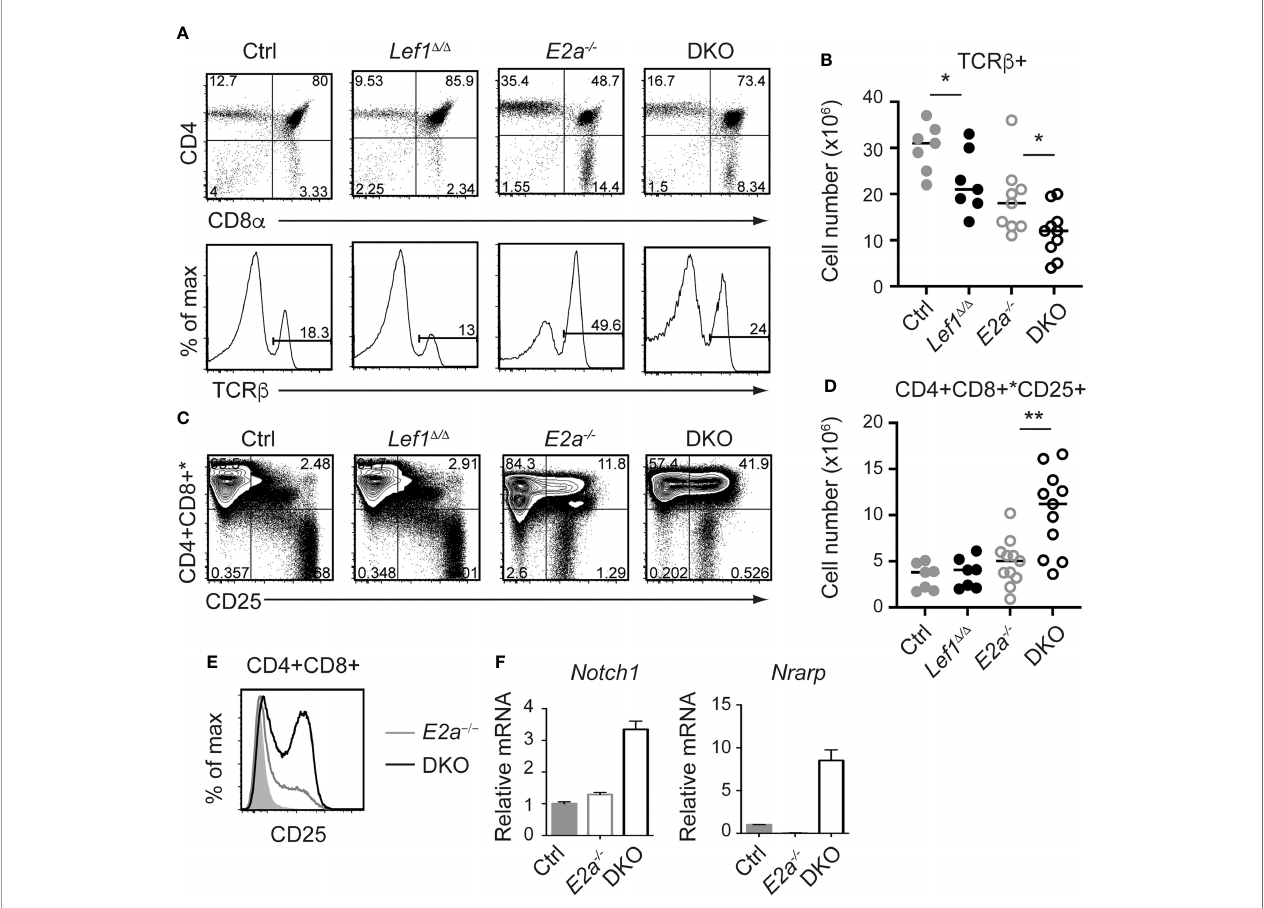
FIGURE 4 | LEF1 restrains expression of CD25, Notch1 , and Nrarp in E2a -/- CD4 + CD8 + thymocytes. (A) Flow cytometry showing CD4 and CD8 (top) or TCR b (bottom) on thymocytes from mice of the indicated genotype. (B) Summary of the number of TCR b + thymocytes in the indicated strains. (C) Flow cytometry showing expression of CD4 and CD8 (* indicates CD11b, CD11c, CD3e were also in this panel) and CD25. *p < 0.05, Student ’ s t-test. (D) Total number of CD4 + CD8 + *CD25 + cells in mice of the indicated genotype. **p < 0.01, Student ’ s t-test. (E) Flow cytometry of CD25 on CD4 + CD8 + thymocytes from WT (shaded), E2a -/- (grey) and DKO (black) mice. (F) qRT-PCR for Notch1 and Nrarp on sorted CD4 + CD8 + thymocytes from mice of the indicated genotype. Data is representative of >6 mice (A-D) or 2 experiments (E, F) . Mice were 5-7 weeks of